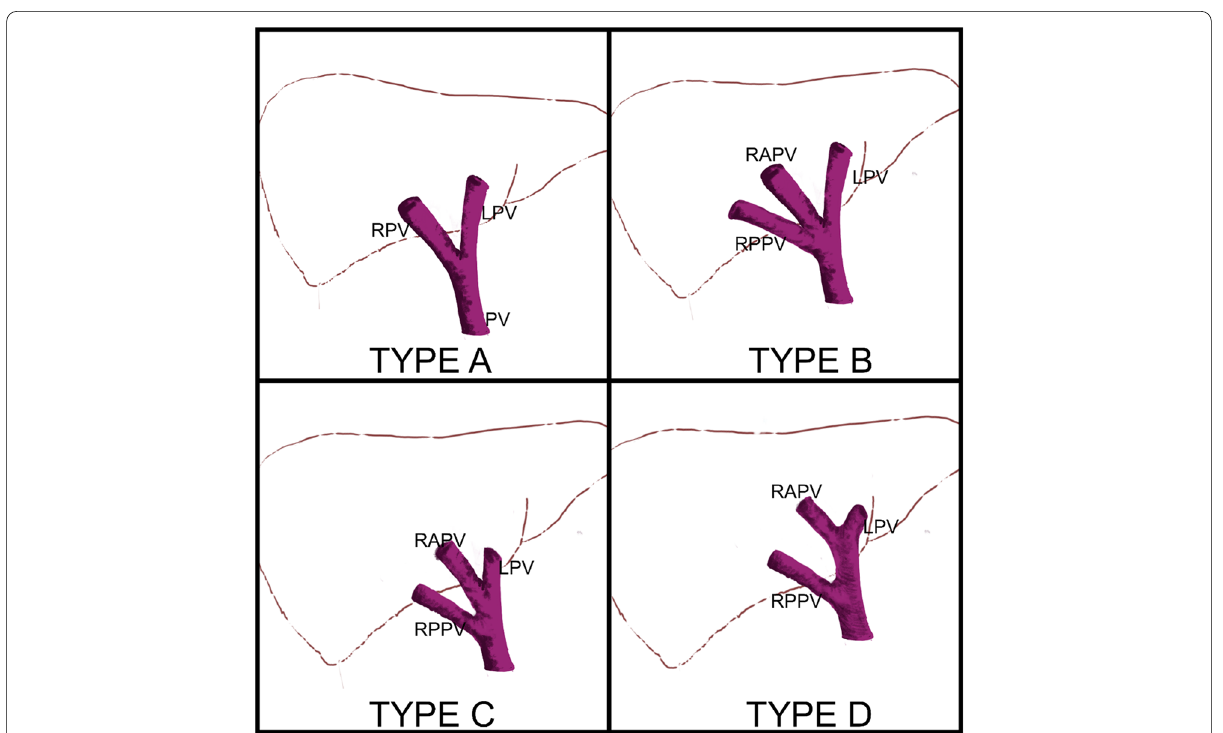
Fig. 4 Schematic representation of portal vein branching variants in our study (excluding the miscellaneous variants). Type A Normal bifurcation into right portal vein (RPV) and left portal vein (LPV). Type B Trifurcation. Type C Early branching of right posterior portal vein (RPPV) with extrahepatic bifurcation between right anterior portal vein (RAPV) and left portal vein (LPV). Type D Early branching of right posterior portal vein (RPPV) with intrahepatic bifurcation between right anterior portal vein (RAPV) and left portal vein (LPV)